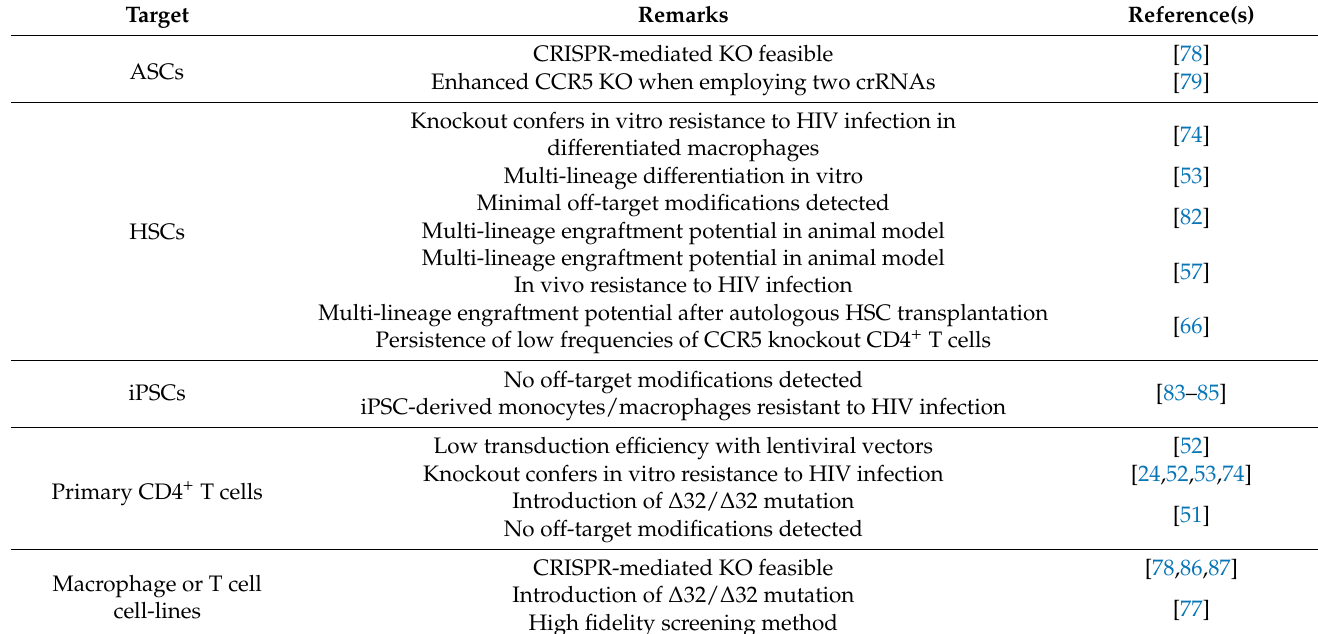
Table 2. CRISPR-mediated gene editing of